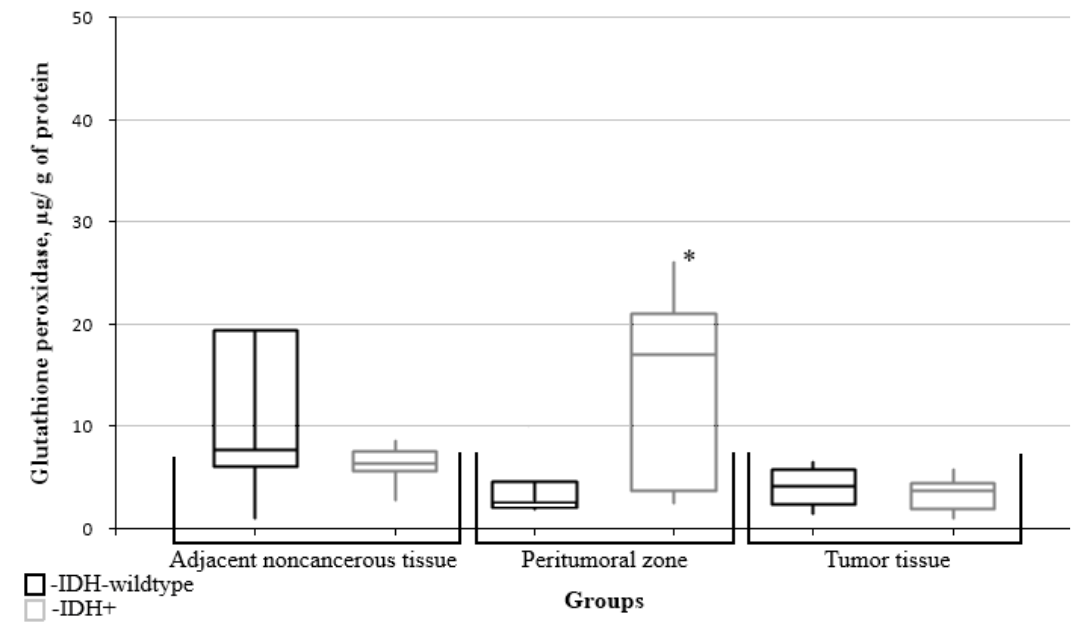
Figure 8. Medians and interquartile ranges (IQRs) of glutathione peroxidase levels in glial tumor tissue as a function of the IDH1 isocitrate dehydrogenase isoenzyme gene mutation. There are significant differences of the glutathione peroxidase levels between the peritumoral zone tissues (*—Mann-Whitney U-test p = 0.043) and the groups with Wild type IDH1 and those expressing the IDH1 mutation. The glutathione peroxidase content in tumor tissues was significantly higher in the p53 group (Figure 9).